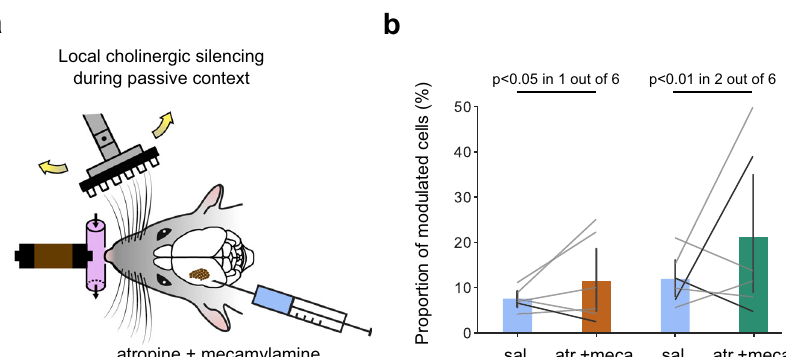
Fig. 5 Pharmacological blockade of cholinergic transmission in the barrel cortex does not reduce the proportion of odor-modulated cells. a Schematics of local silencing of cholinergic transmission with 1 mM injections of atropine (atr.) and mecamylamine (meca.) in barrel cortex during the passive stimulation context. b Proportion of modulated cells with and without unilateral cholinergic silencing (mean saline = 7.57% (5.93, 9.34); mean atr. + meca. = 11.59% (4.87, 18.63); P = 0.463; grating + odor versus grating only (orange); mean saline = 11.98% (8.17, 16.28); mean atr. + meca. = 21.24% (8.93, 35.75); P = 0.6; odor only versus blank (green); n = 12 sessions from three mice; Wilcoxon signed-rank test). Black lines indicate pairs of sessions with a signi fi cant change in the proportion of modulated cells (Chi-square test). Error bars indicate 95% con fi dence intervals for the mean. All tests